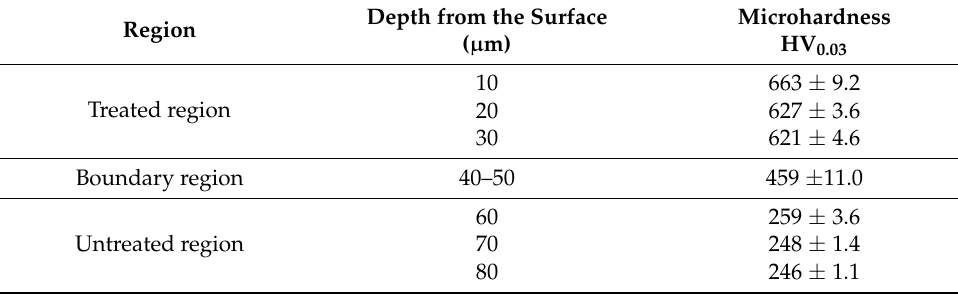
Figure 9. Indentation marks (HV 0.03 ) on the cross-section of the untreated sample ( a ) and on laser- treated sample ( b – d ). Table 3. Microhardness profile as function of depth from the surface.